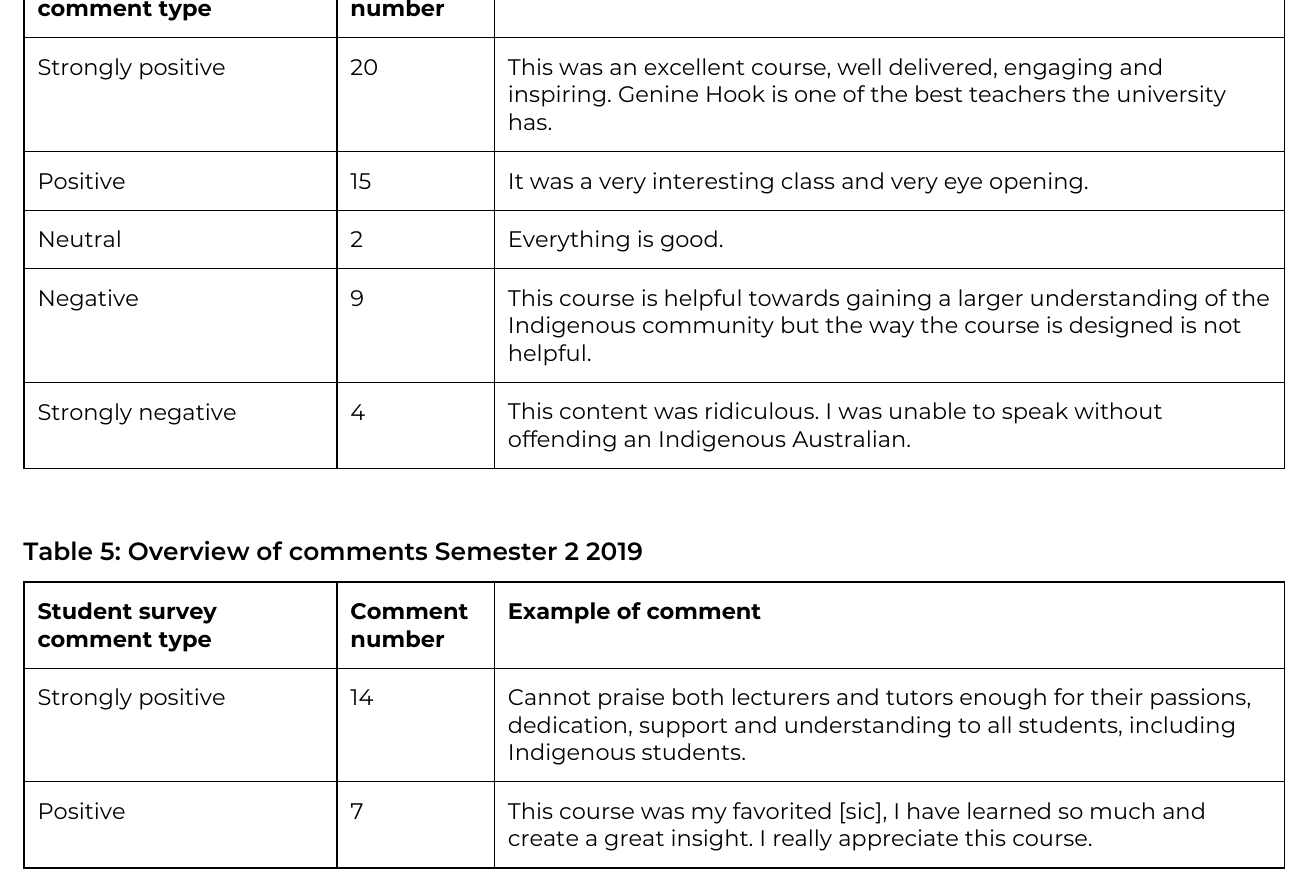
Table 4: Overview of comments Semester 1 2019 Student survey